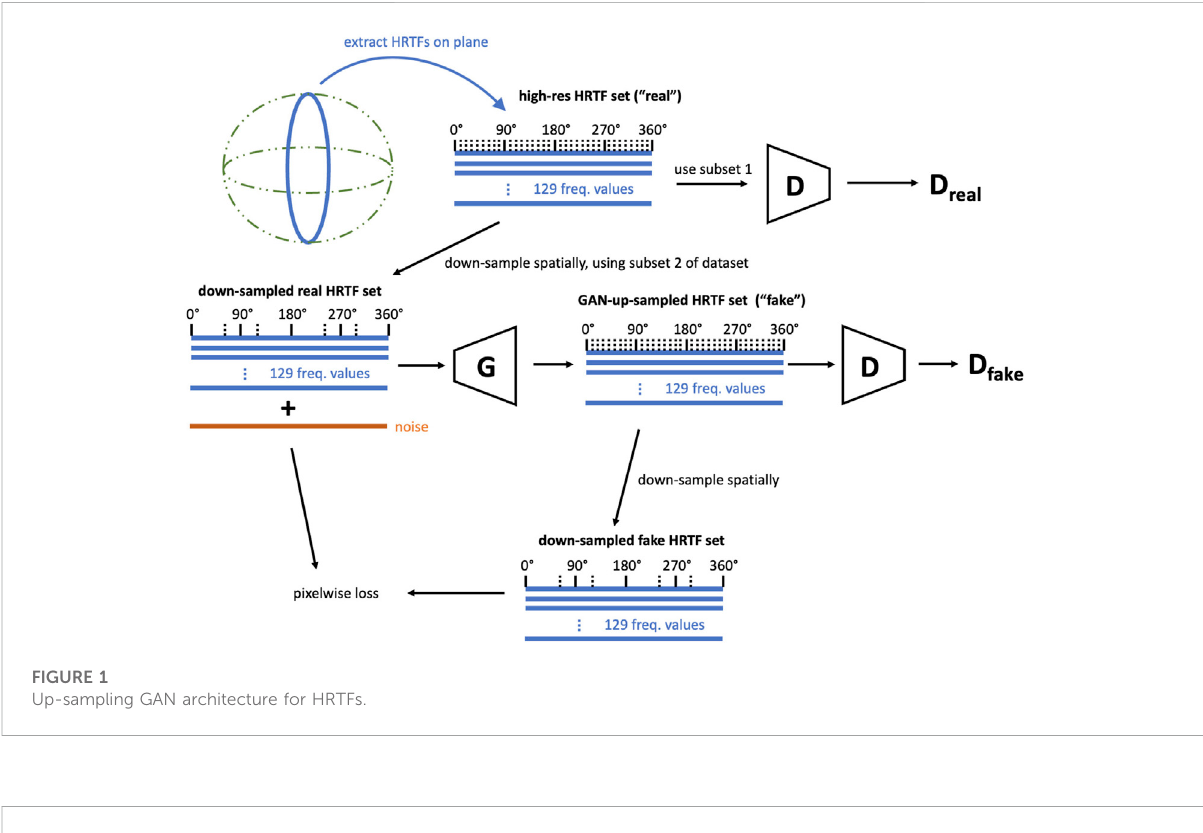
FIGURE 1 Up-sampling GAN architecture for HRTFs.